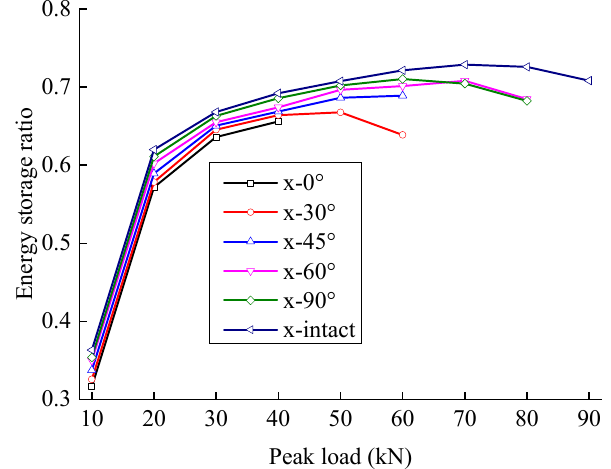
Figure 10. Dissipated energy evolution curve of fractured sandstone with different crack angles.